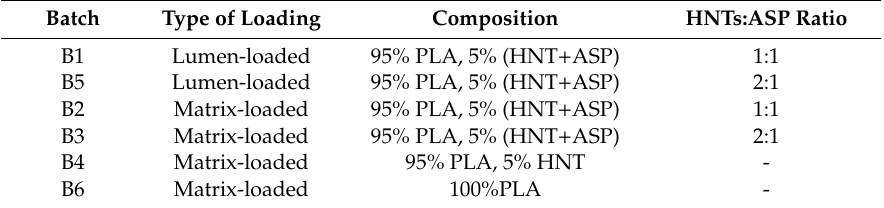
Table 1. Description of the prepared sample batches, the method of processing, composition and ratio of each component for each